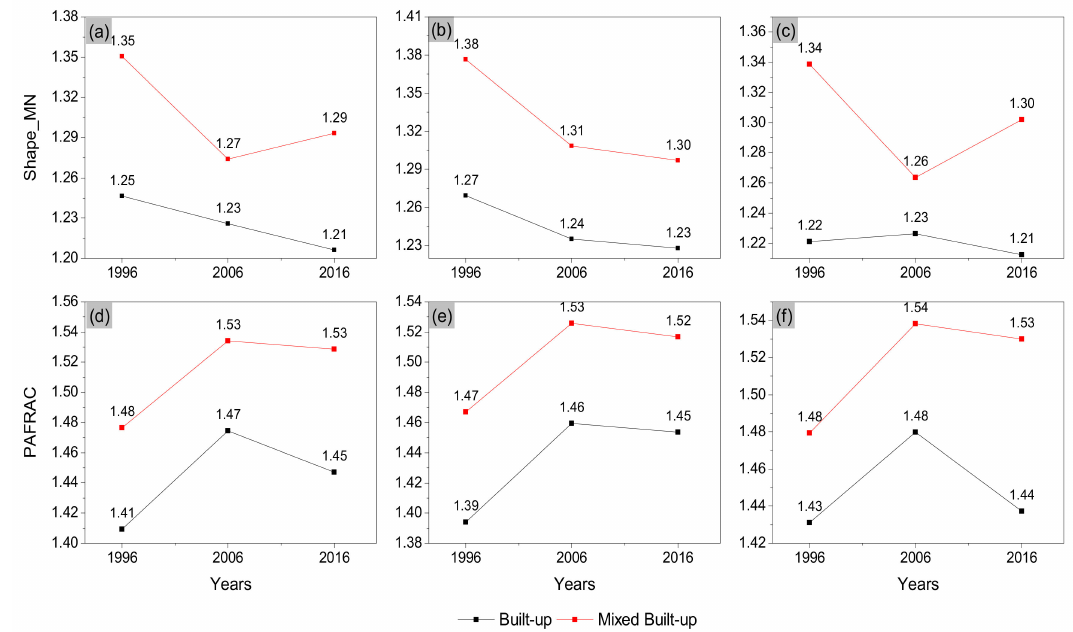
Figure 11. Class level Shape_MN and PAFRAC of built-up and mixed built-up classes; ( a – c ) present the Shape_MN of built-up and mixed built-up class for KMA, KMA-urban, and KMA-rural, respectively, in 1996, 2006, and 2016; and ( d – f ) show the results of PAFRAC for KMA, KMA-urban, and KMA-rural, respectively, in 1996, 2006, and